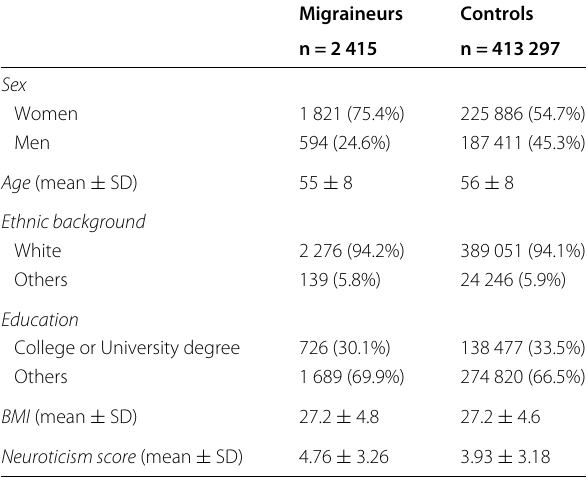
Table 1 Socioeconomic and demographic characteristics of the